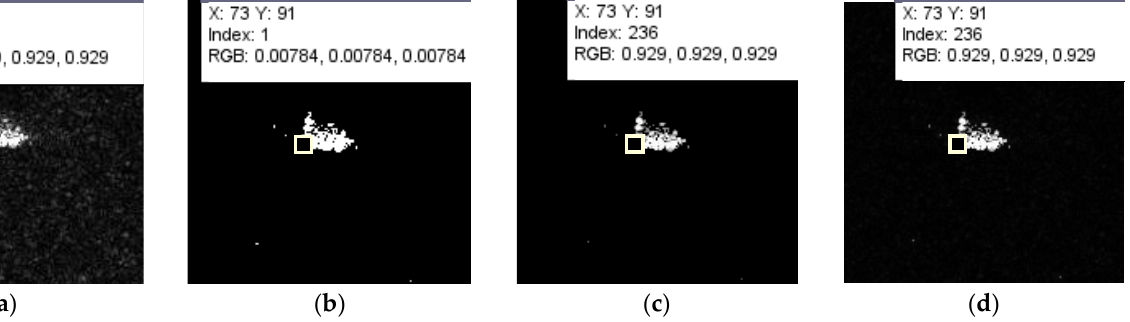
Figure 3. Each stage of ADMF method: ( a ) original image; ( b ) binary image; ( c ) Multiplicative filtered image; and ( d ) proportion weakened image.